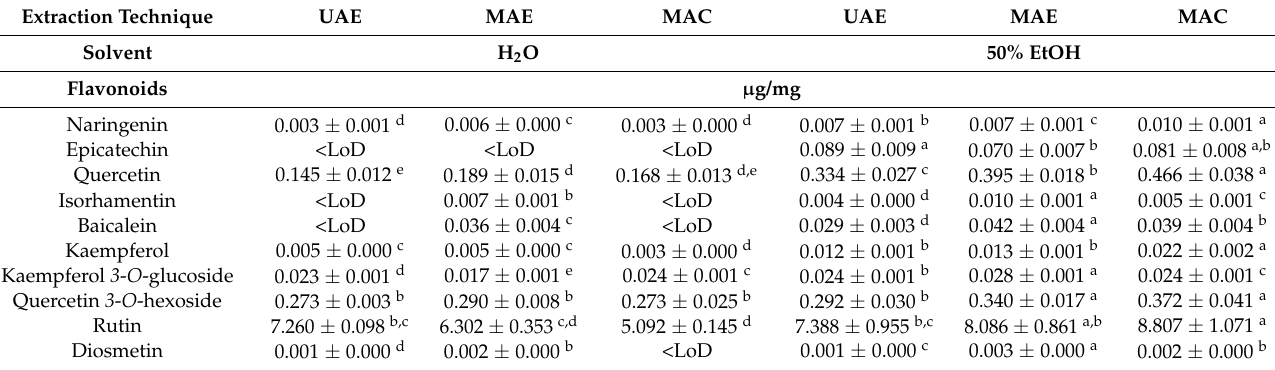
Table 2. Concentration * of detected ** flavonoids in elderberry extracts ( µ g/mg